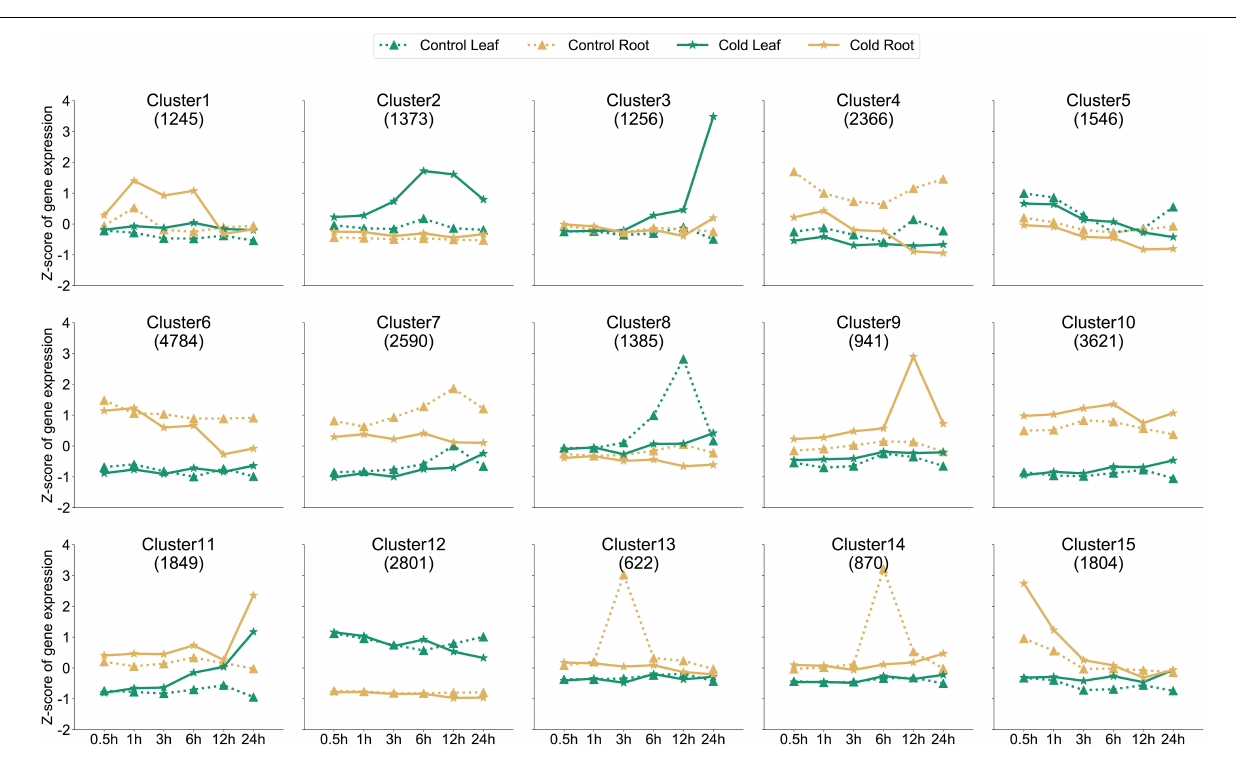
FIGURE 2 | Dynamics of gene expression in all samples. k -Means clustering was used to group the expression profiles of the transcriptome into fifteen clusters. The X-axis depicts values at six time points, and the Y-axis depicts the z -score standardized per gene. The dotted line represents the roots and leaves of the control, and the solid line represents the roots and leaves of cold stress-treated tissues; different marks represent different organizations. The numbers shown in each box (example: 1,245 genes for cluster 1) indicate the number of genes in that